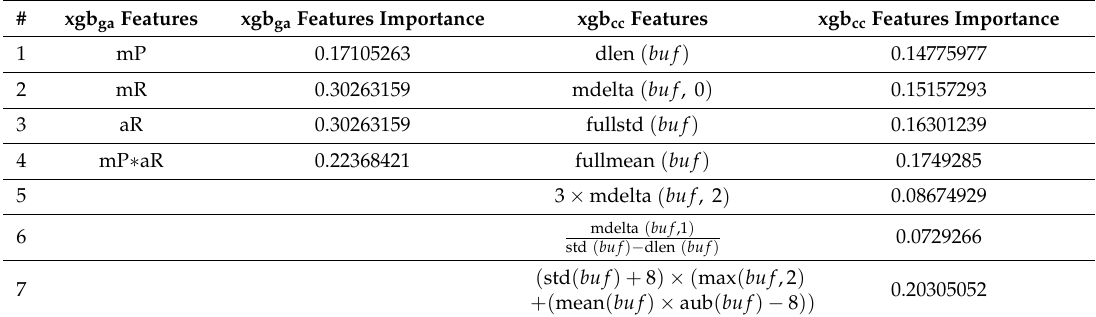
Table 11. Evolved features.